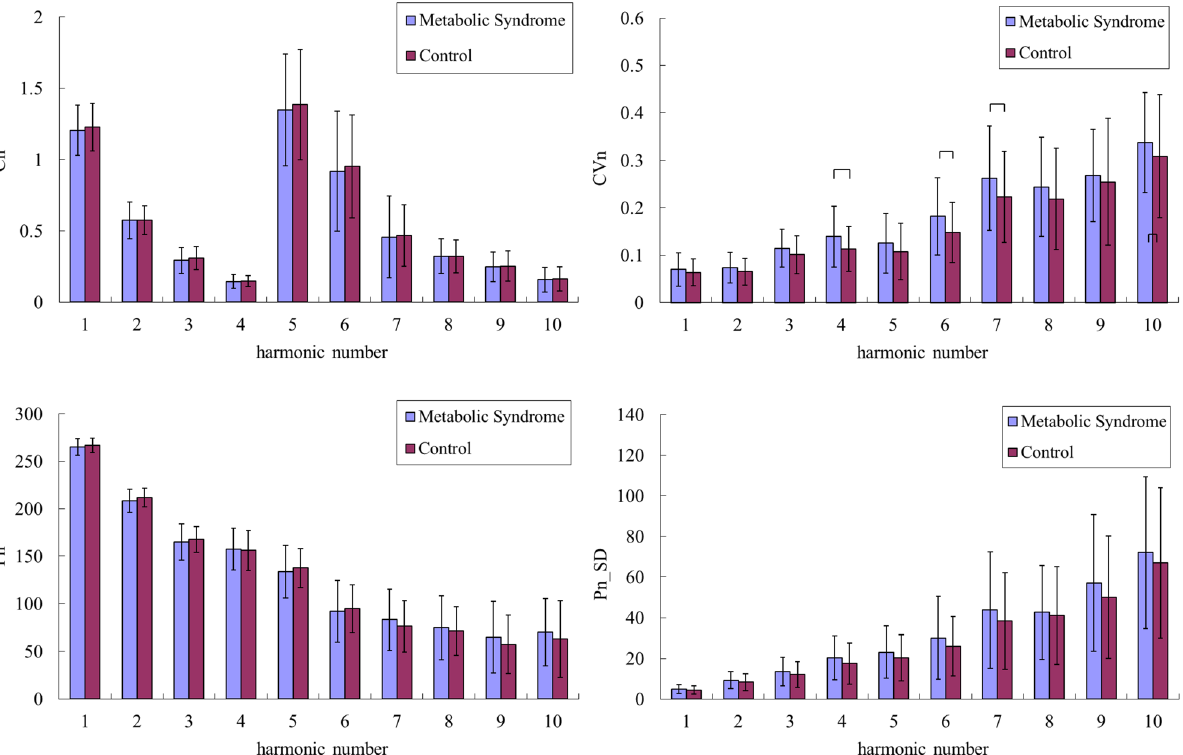
Figure 4. Comparisons of BPW harmonic indices in all subjects between with and without pre-MetS: C n , CV n , P n , and P n _ SD . Data are mean and SD values. C 5 – C 10 values have been multiplied by 10 to make the differences clearer. “ (cid:6437) ” indicates p < 0.05. Only CV 4 , CV 6 , and CV 7 differed significantly between with and without pre-